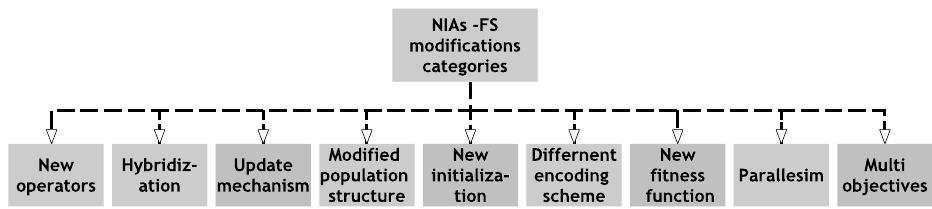
Figure 3. NIAs FS modifications